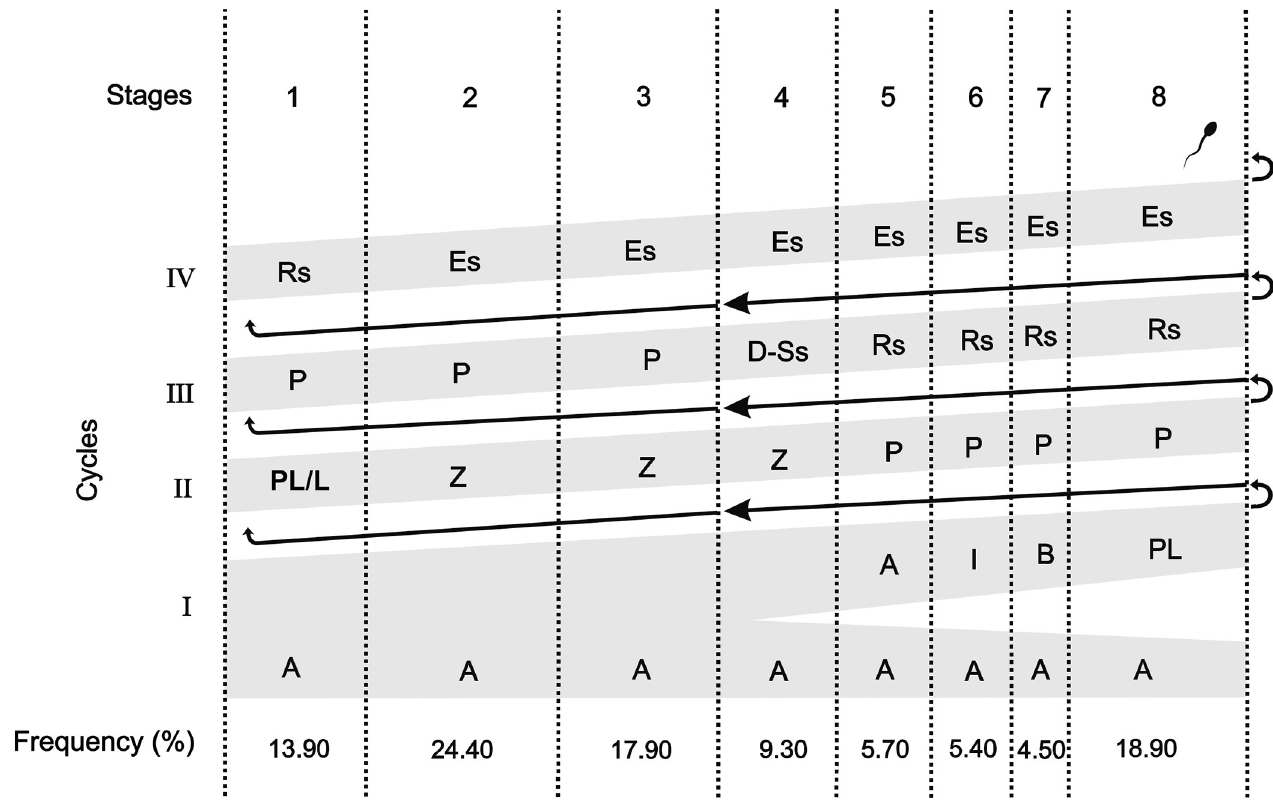
Fig 3. Diagram of the spermatogenic process of Diphylla ecaudata representing the progression of the germ cells alongside the stages of the seminiferous epithelium cycle and the frequency (%) of each stage. Each row corresponds to a generation of spermatogenic cells and each column corresponds to a stage. Roman numbers indicate the cycles of cell division necessary to complete the spermatogenesis process. A: Type A spermatogonia; I: Intermediate spermatogonia; B: Type B spermatogonia; PL/L: Preleptotene/Leptotene primary spermatocyte; Z: Zygotene primary spermatocyte; P: Pachytene primary spermatocyte; D: Diplotene primary spermatocyte; Ss: Secondary spermatocyte; Rs: Round spermatid; Es: Elongated spermatid.